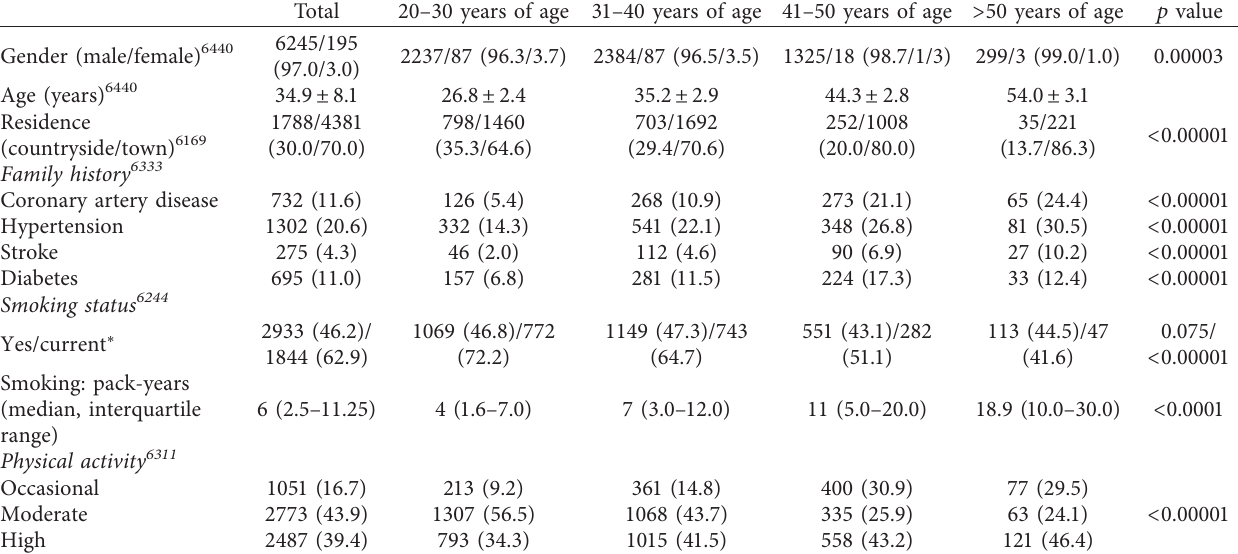
Table 1: Sociodemographic data.